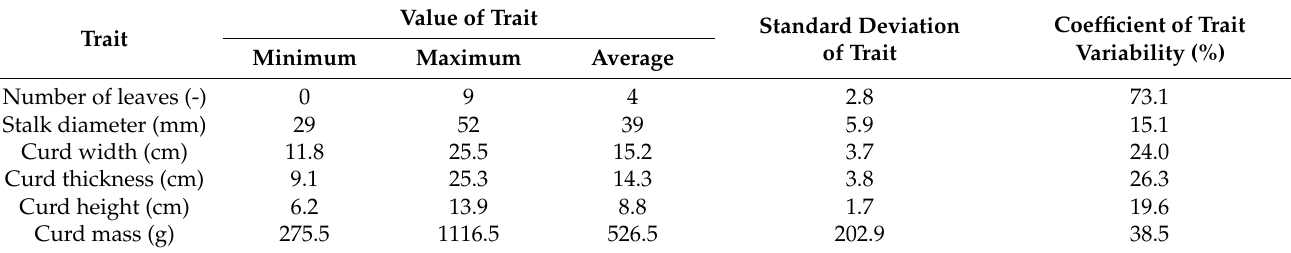
Table 1. Statistical distribution of the morphometric traits of broccoli inflorescences.